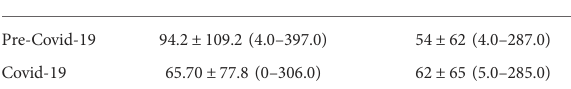
TABLE 2 Age at diagnosis and time to treatment order and 1st injection. Days from Dx to order Days from order to